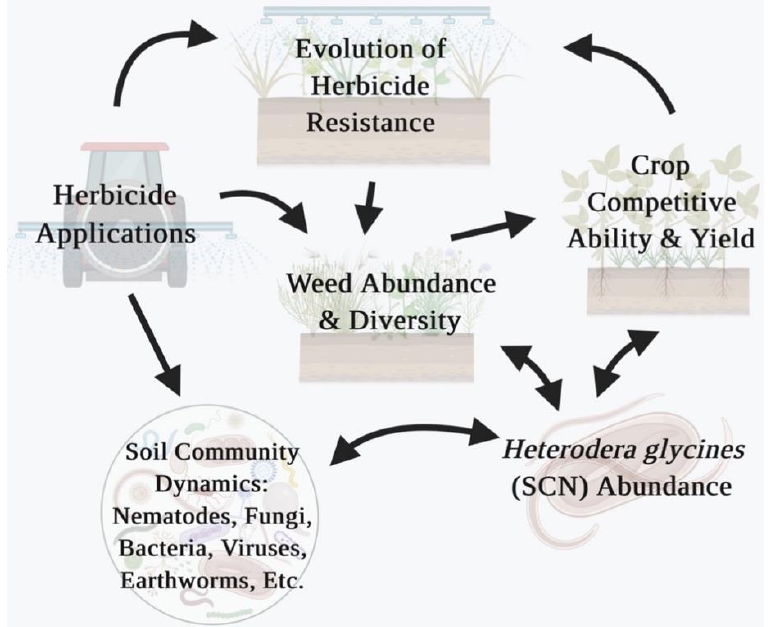
Figure 1. Example of potential eco – evo feedbacks in the crop-weed – SCN-management interaction in agroecosystems with reliance on herbicide for weed management. Created with BioRender ® (BioRender.com).